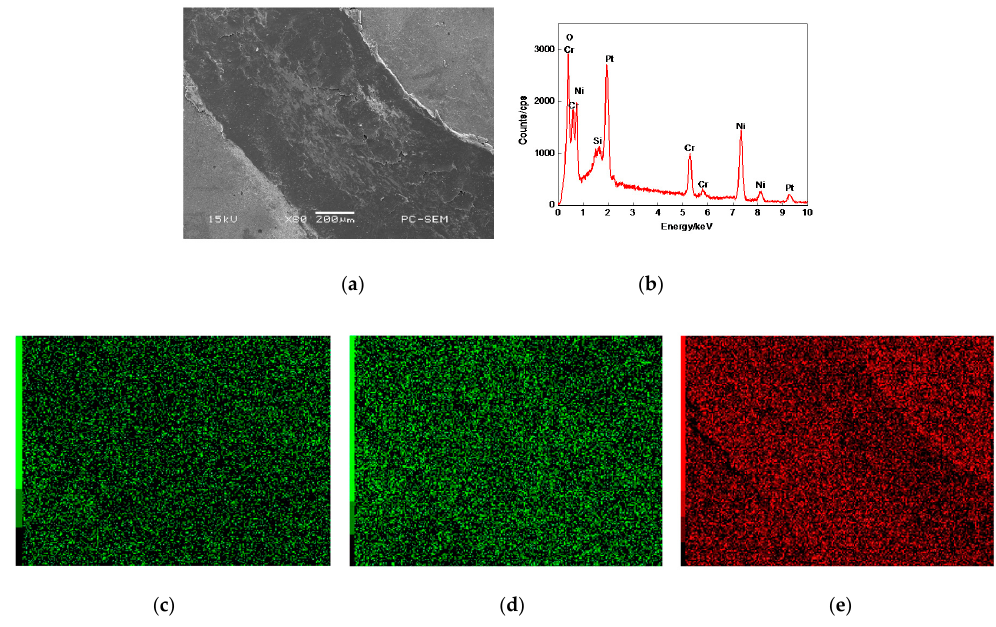
Figure 16. Plane scan analysis of worn track on 17% Cr–83% Ni coating. ( a ) Plane scanned position; ( b ) Plane scan analysis of worn track on 17% Cr–83% Ni coating; ( c ) Distribution of Cr content; ( d ) Distribution of Ni content; ( e ) Distribution of O content.